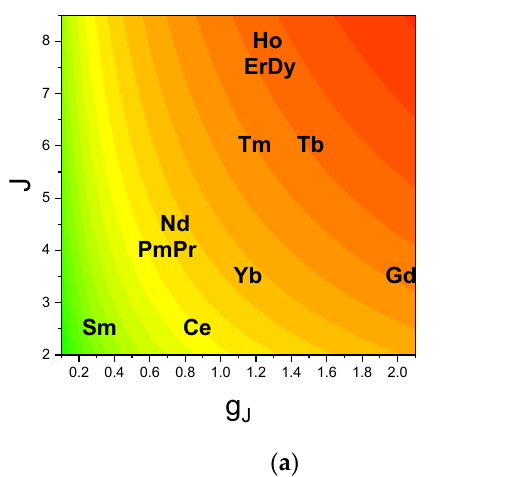
Figure 6. Solomon ( a ) and Curie ( b ) dependences on J and g J of nuclear transverse relaxation. The colors indicate the amplitude of the factors in the equations for R Solomon and R Curie in front of the parentheses containing the spectral density functions, to be divided by r 6 , with r in